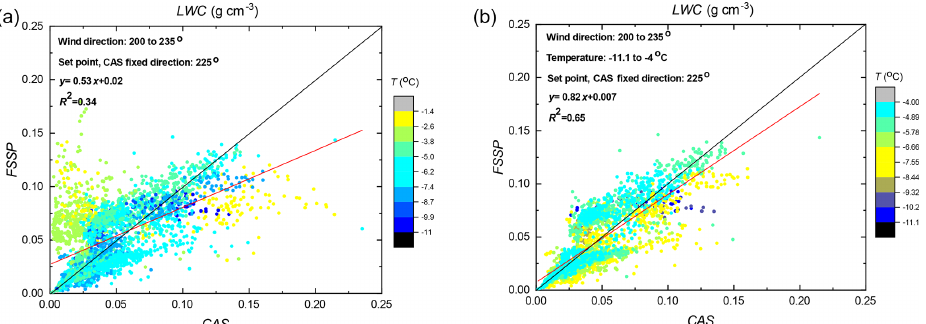
Figure 10. (a) Comparison of LWC as it was derived from the CAS and FSSP for wind iso-axial conditions, color code represents full temperature range from − 11 . 1 to − 1 . 4 ◦ C. (b) Comparison of LWC as it was derived from the CAS and FSSP is presented for the same conditions but only for the temperature range from − 11 . 1 to − 4 ◦ C.